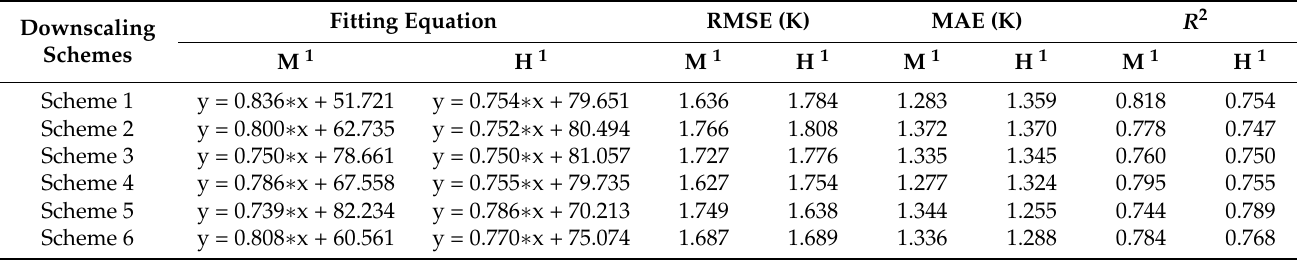
Table 10. Statistical parameters for the fitting lines of scatters in MFGWML and HUTS for the six downscaling schemes performed around the central urban